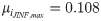
Moderate coupling produces bursting phenomena in noisy systems (model GR with p = 0).(A) Evolution of ccyt in a particular cell of the graph and in two neighbors with no gap junctional coupling (d = 0). Changes in ccyt occur independently in each cell and even after long periods (t = 555), no coherent (synchronous) behavior is observed (see also S3 Movie). (B) When gap junctional coupling is augmented to low values d = 0.0015), the system hardly synchronizes. Small bursting phenomena (between time 100 and 200) are observed before synchronization, see S4 Movie. (C) The gap junctional coupling is set to a high value (d = 0.009); synchronization occurs easily between the neighboring cells and a coherent behavior is observed, see S5 Movie. (D) The wave is represented at different time points with the settings of panel (C). Histograms in (A-C) represents the distribution of the phase differences of two arbitrary chosen neighboring cells, illustrating the synchronization measure. Here msync = 0.07 in (A), msync = 0.19 in (B) and msync = 0.58 in (C). All parameters are set according to Table 1 with high noise and μiJINF,max=0.108.